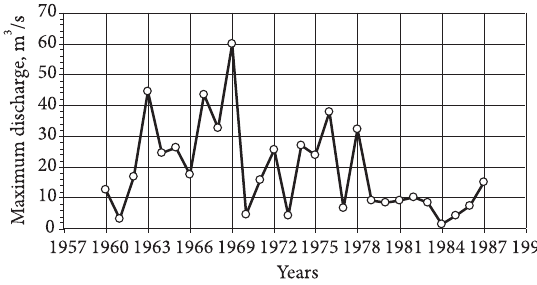
Fig. 4. Variation of maximum flow values of Goksu stream in different years (dam construction was started in 1987 and completed in 1995)